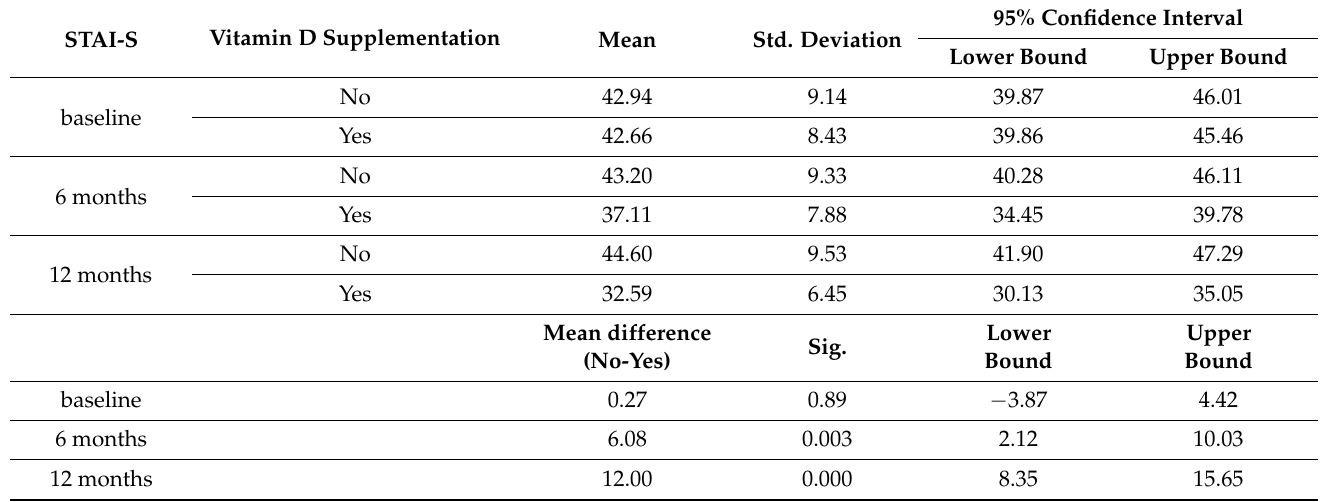
Post hoc pairwise comparisons using the Bonferroni correction, after general linear models for repeated measures were used to compare the STAI-S scores between different time